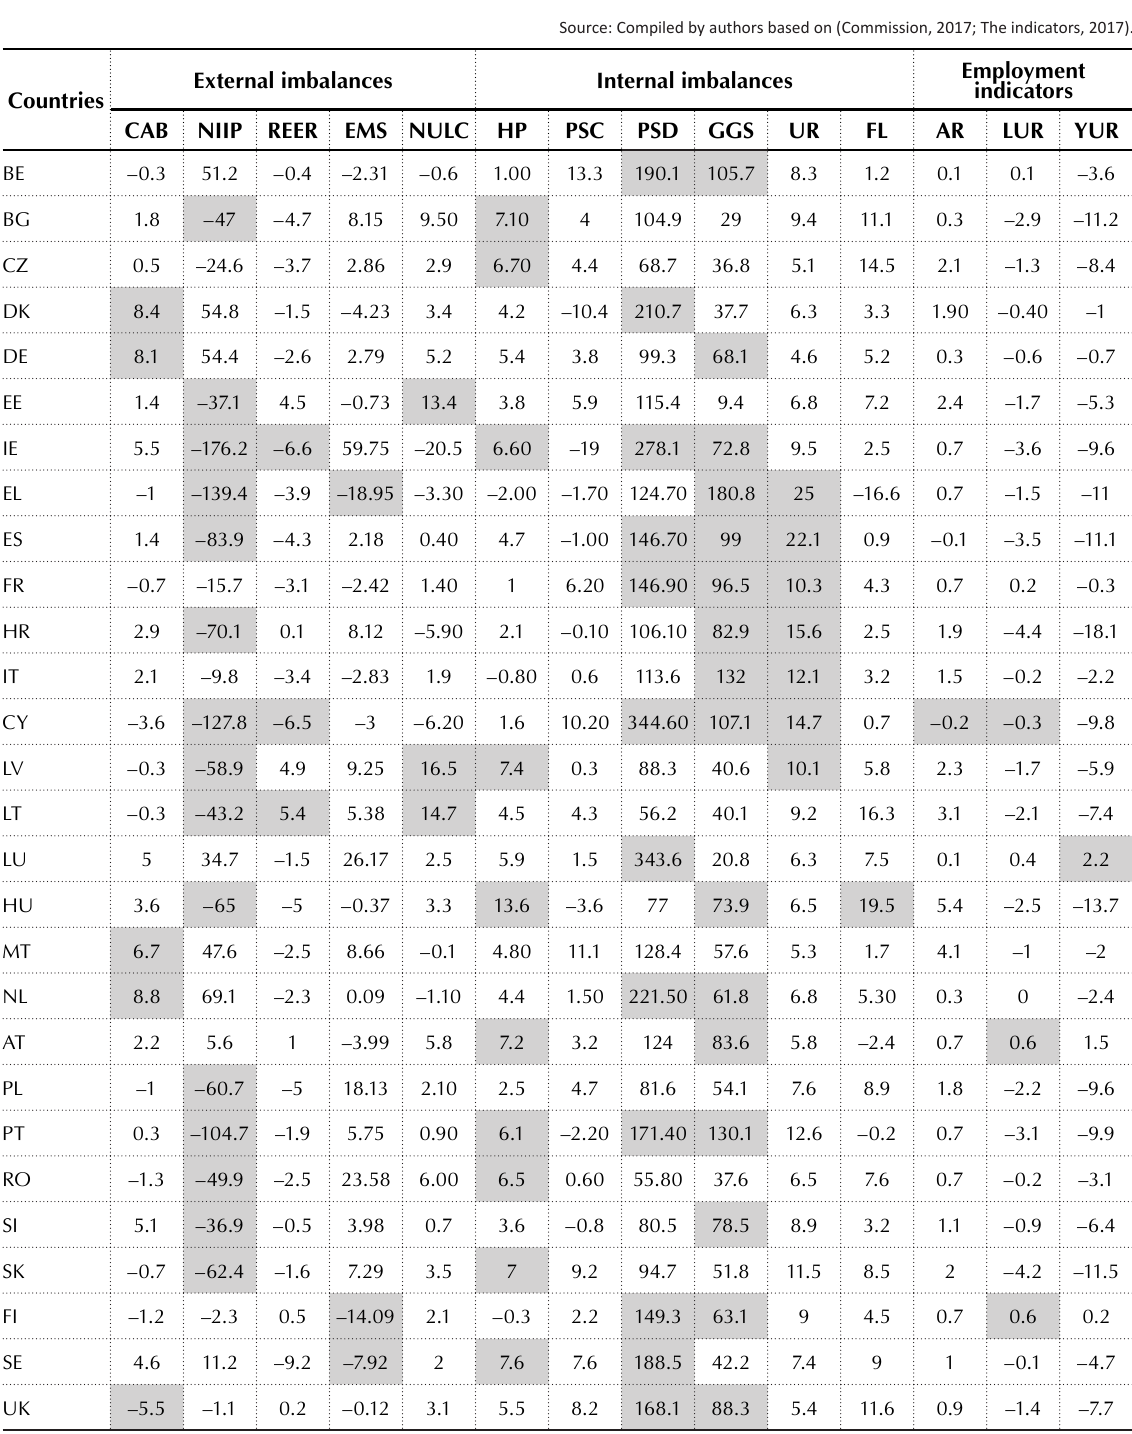
Table 3. MIP Scoreboard